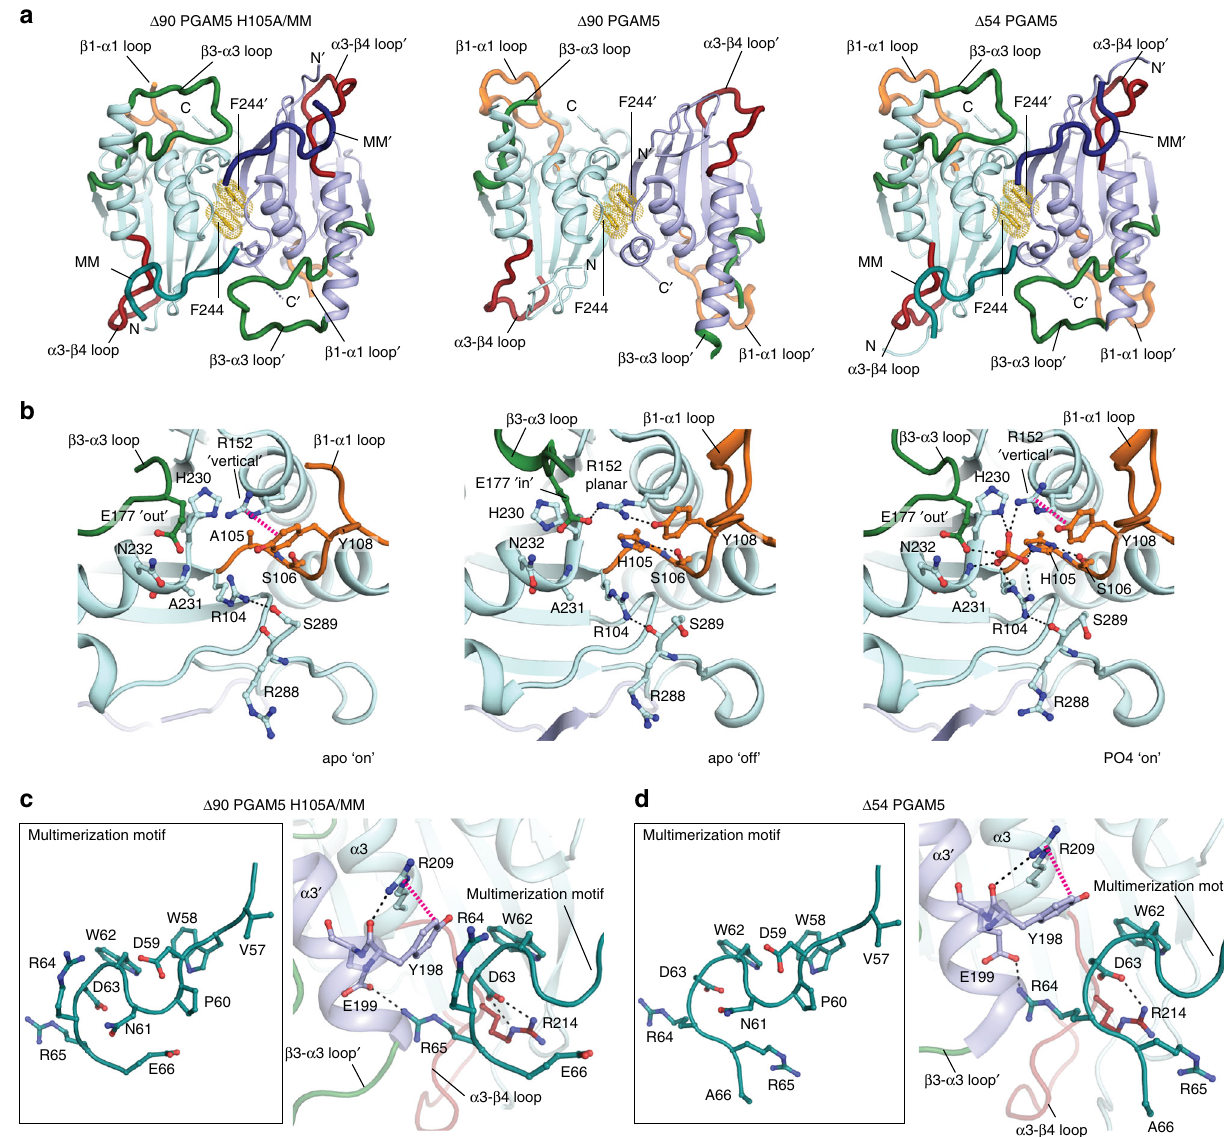
Fig. 3 Key features of PGAM5 activation in the crystal structure of Δ 90 PGAM5 H015A/MM. a The structures of Δ 90 PGAM5 H105A with the multimerization motif (MM) added in trans ( Δ 90 PGAM5 H105A/MM) (left panel) compared to the structures of Δ 90 PGAM5 (PDB: 3MXO) (middle panel) and Δ 54 PGAM5 with the MM present in cis (PDB: 5MUF) (right panel). Monomers 1 and 2 are colored cyan and light blue, respectively, in all structures with their corresponding MM regions colored in teal (monomer 1 MM) and dark blue (monomer 2 MM) where present. The β 1 – α 1 loop is indicated in orange, the β 3 – α 3 loop is indicated in green, the α 3 – β 4 loop is indicated in red. The F244 residues in the central axis forming the dimer interface are indicated in yellow. b Detailed view of the catalytic core in Δ 90 PGAM5 H105A/MM (left), Δ 90 PGAM5 (middle), and Δ 54 PGAM5 (right) highlighting interactions between active-site residues and the phosphate ion (PO 4 ). c , d Comparison of the MM architecture (left panel) and the differences in interactions with the phosphatase domain (right panel) for c Δ 90 PGAM5 H105A/MM and d Δ 54